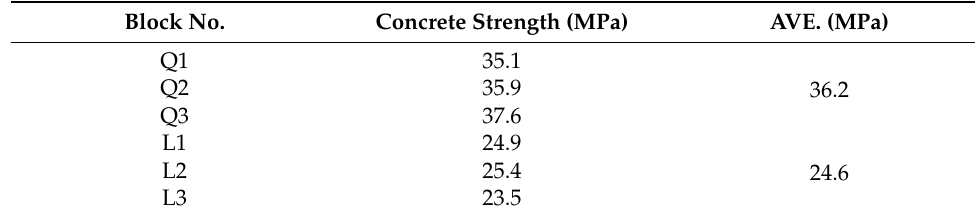
Table 3. Measured strength of